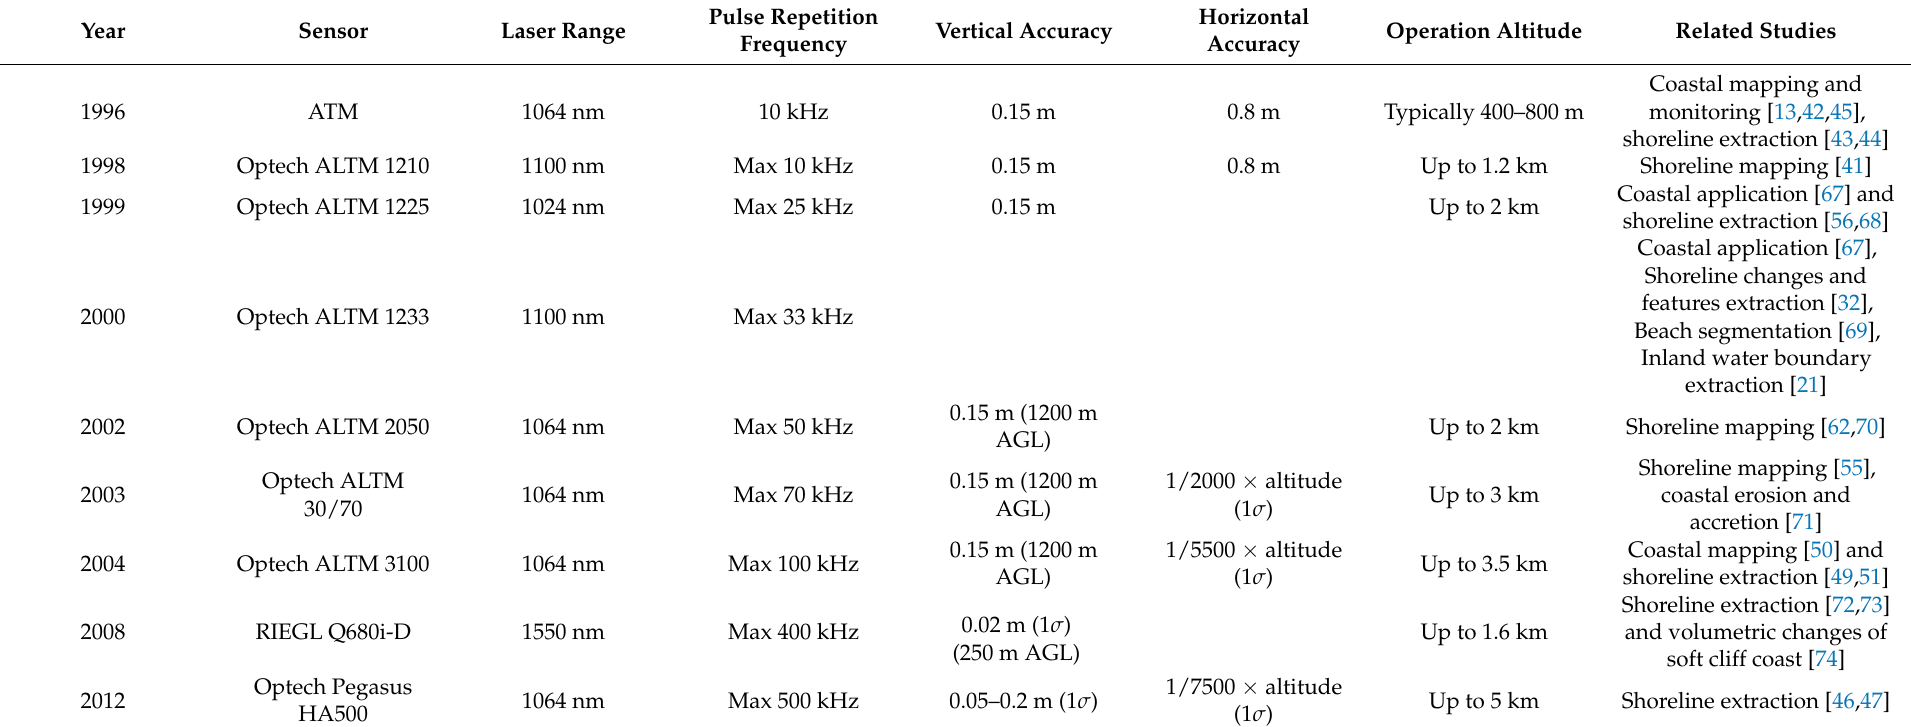
Some parameters of ALT are referenced from Shan and Toth [57], Bakuła [75], García-Quijano et al. [76], Pfennigbauer and Ullrich